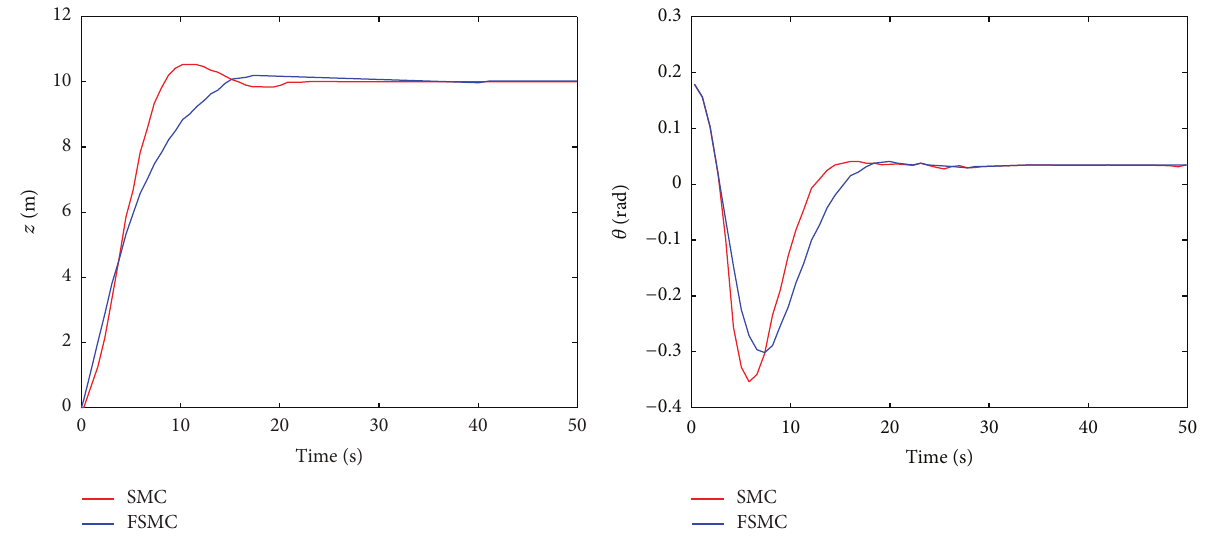
Figure 5: Changing curves of depth and pitch